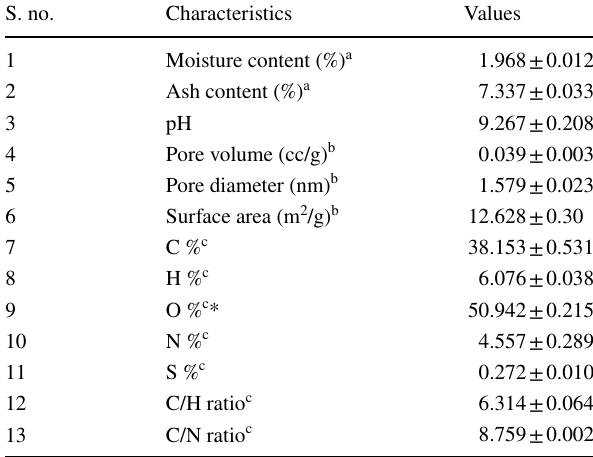
Table 2 Characteristics of bagasse